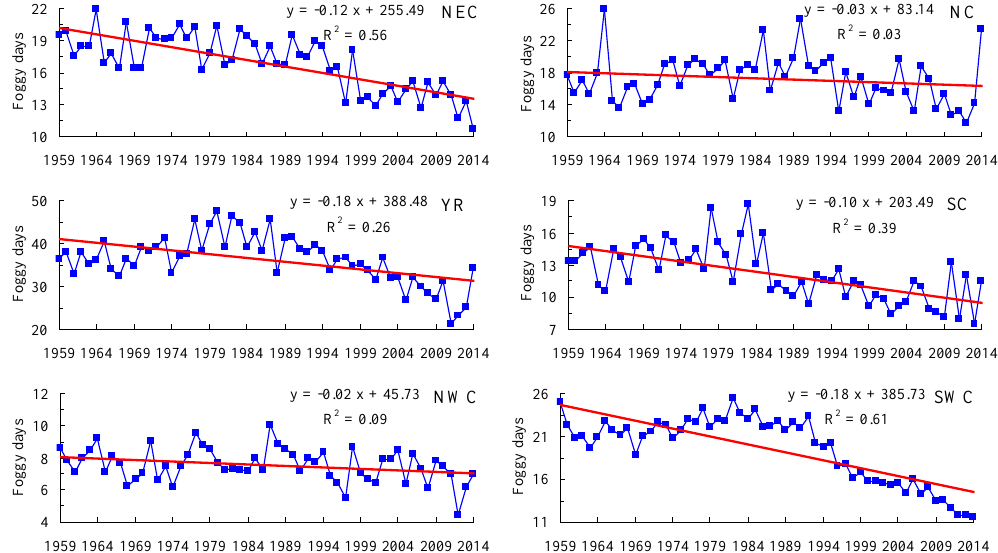
NEC y = -0.12 x + 255.49